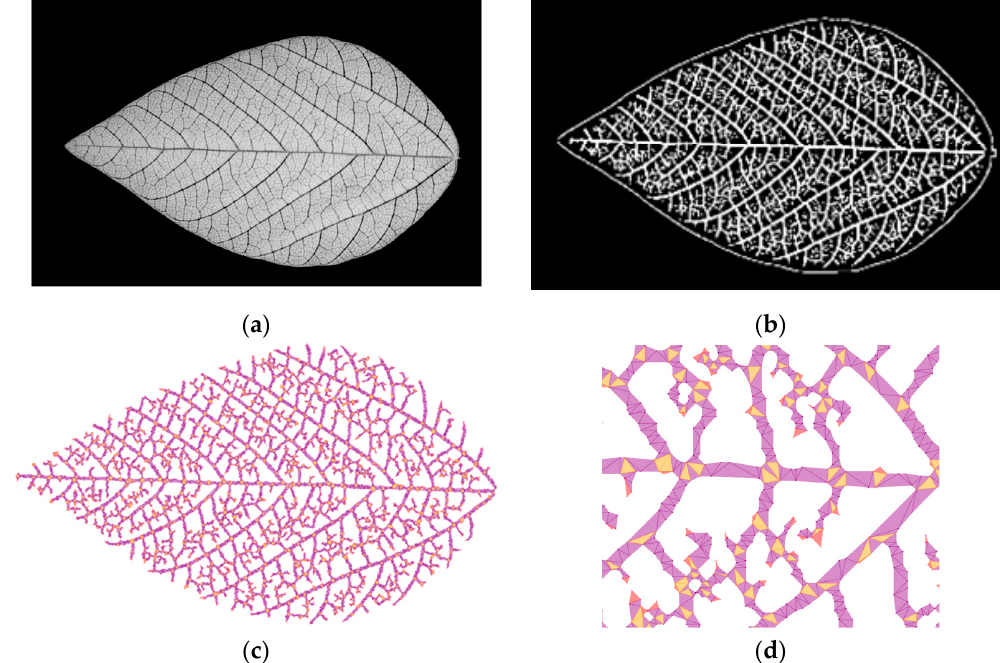
Figure 7. The extraction of leaf venation. ( a ) The NDVI image, ( b ) segmented leaf venation image, ( c ) extracted leaf venation image, ( d ) detail view of the leaf venation image (Yellow dots are junctions; pink dots are tips and purple curves are branches).